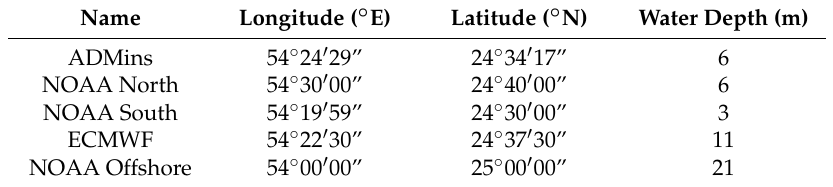
Table 1. ADM ins , NOAA N, NOAA S, ECMWF, NOAA Offshore coordinates, and water